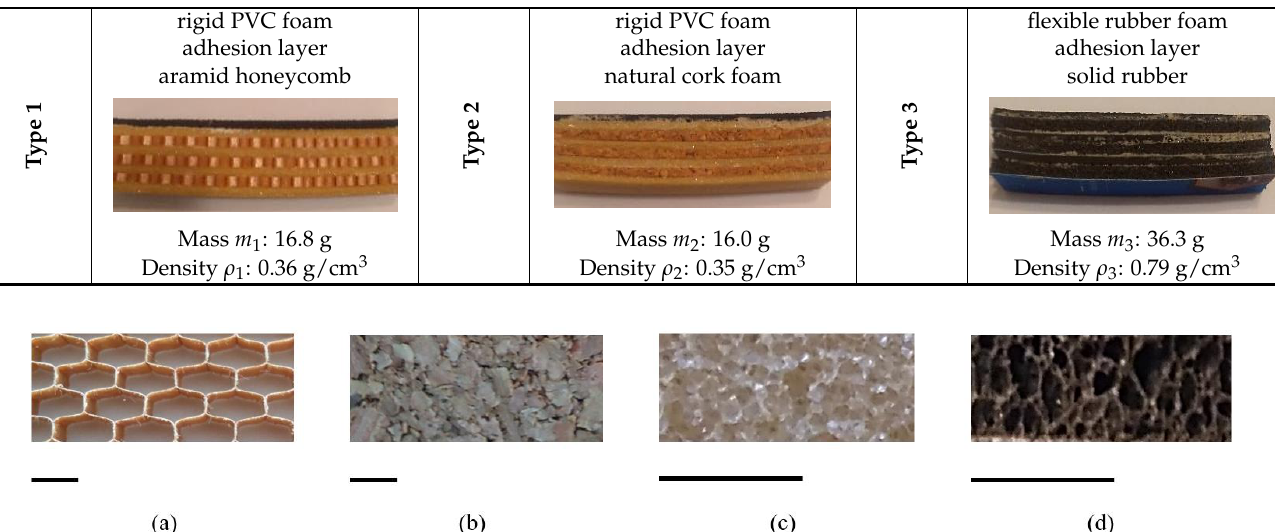
Table 1. Passive damper 1, 2, and 3.